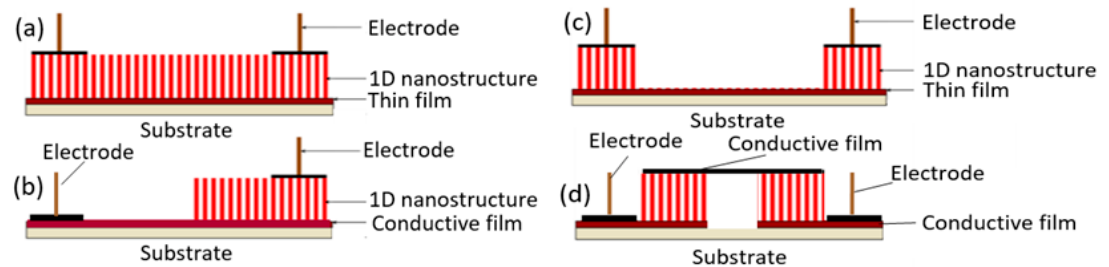
Figure 24. ( a – d ) Schematic diagrams for a multi-nanowire-based sensor with nanotubes, nanowires, or Figure 24. ( a , b , c , d ) Schematic diagrams for a multi-nanowire-based sensor with nanotubes, nanorods oriented in a perpendicular nanowires, or nanorods oriented in a perpendicular direction.